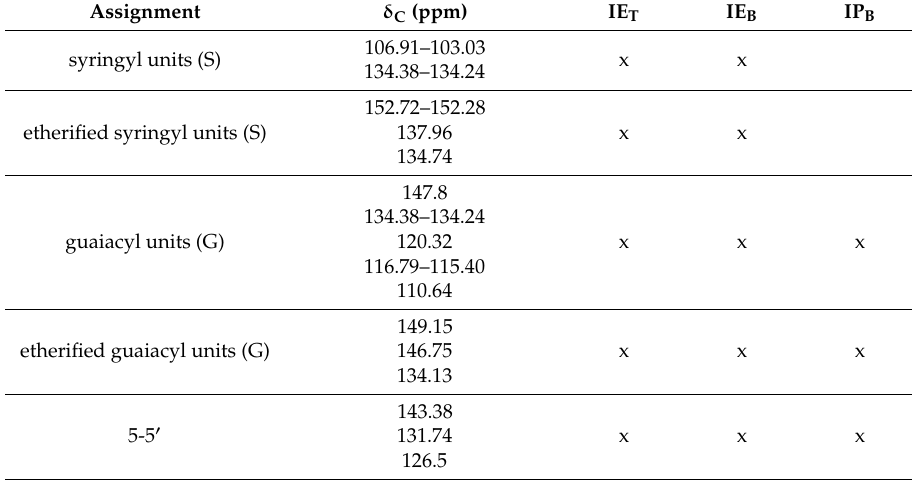
Table 4. Structural units clearly identified in qualitative 13 C-NMR analyses of E. nitens lignins recovered after delignification treatment for both ionic liquids, for comparison, data for the Ionosolv lignin from Pinus pinaster wood ( IP B ) [20] are listed. Chemical shifts used for identification are